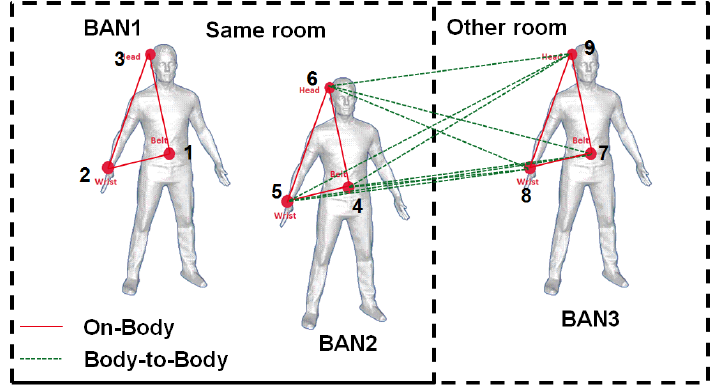
Figure 4. Scenario of several BANs collocated in the same or adjacent rooms.